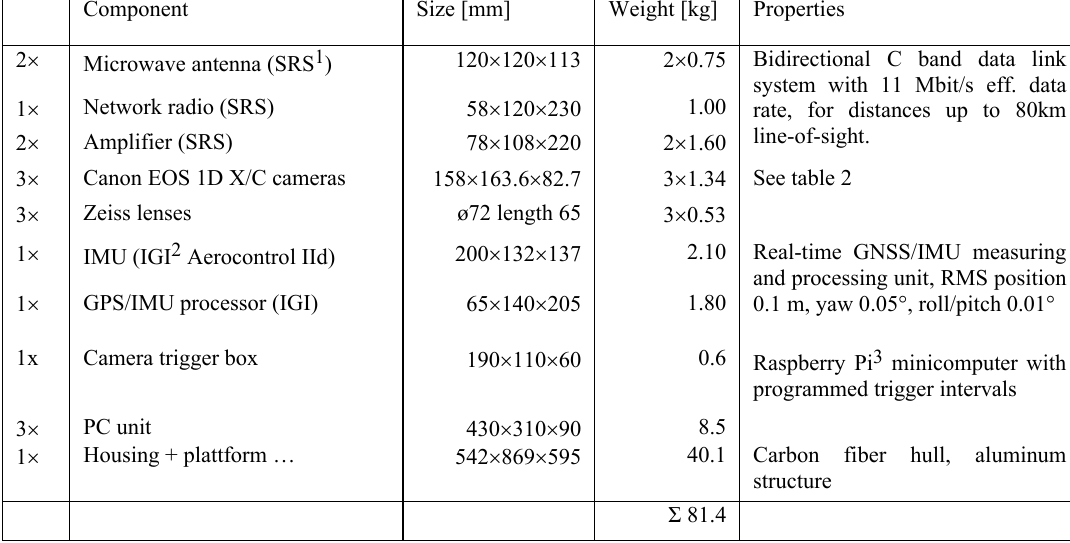
Table 1. Properties of 4k system hardware